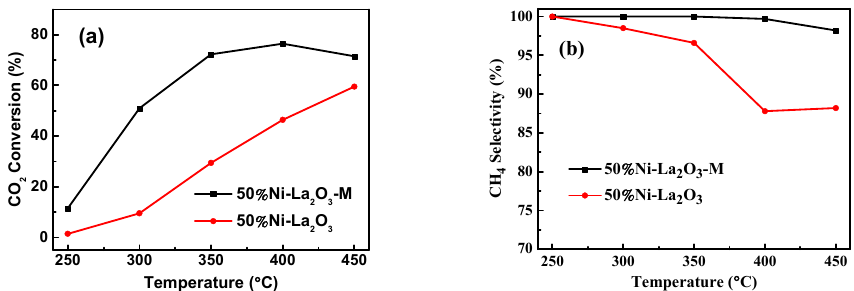
Figure 5. ( a ) CO 2 conversion and ( b ) CH 4 selectivity over 50% Ni–La 2 O 3 –M and 50% Ni–La 2 O 3 in CO 2 methanation reaction at a gas hourly space velocity (GSHV) of 120,000 mL g − 1 h − 1 and 0.1 MPa in the gas mixture of H 2 /CO 2 /Ar = 4/1/5.